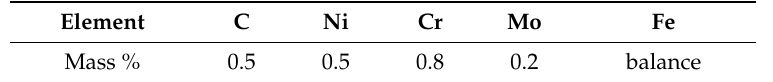
Table 1. Chemical composition of powder metallurgy steels (PMS) used in this investigation.